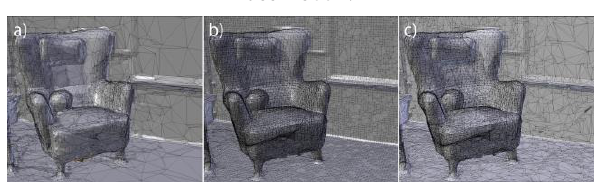
Table 1. Polygon counts of indoor models prior and after decimation.